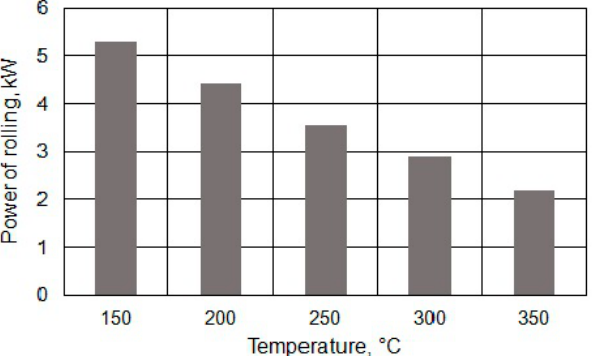
Figure 10. Variation in rolling power for a single roll in the bar rolling process.